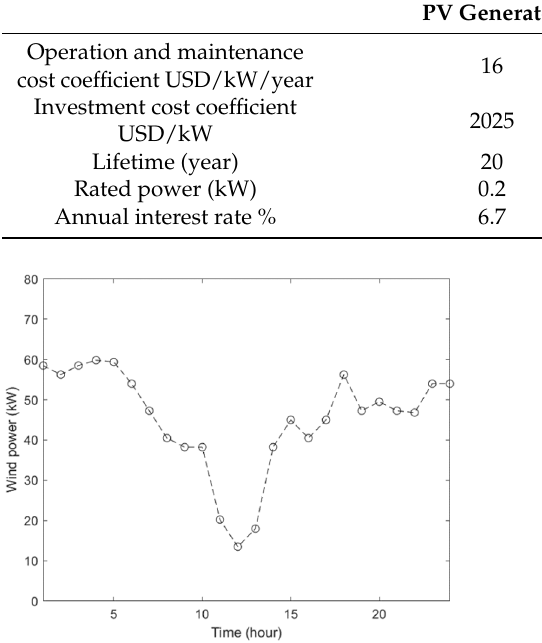
Figure 3. Daily output power of wind turbines.